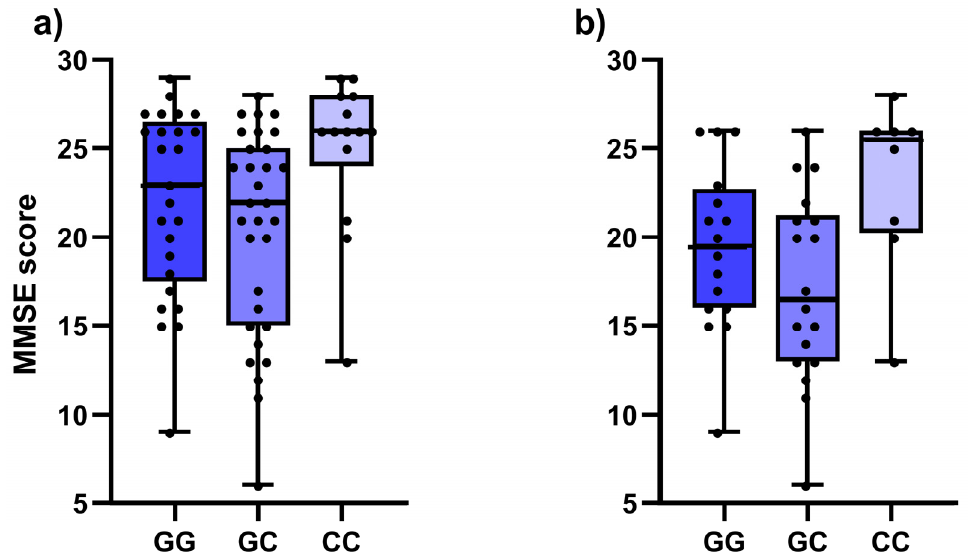
Figure 2. Comparison of the Mini-Mental State Exam (MMSE) scores between different KEAP1 rs1048290 genotypes in: ( a ) whole patient cohort; ( b ) Alzheimer’s disease patients only.